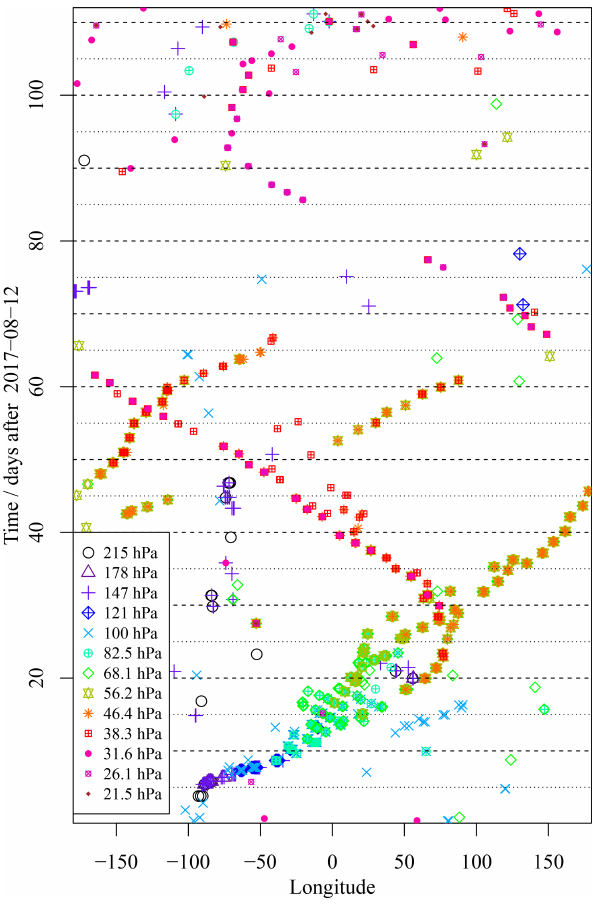
Figure 6. Longitudes of enhanced H 2 O, plotted as a function of time. Colours and symbols represent